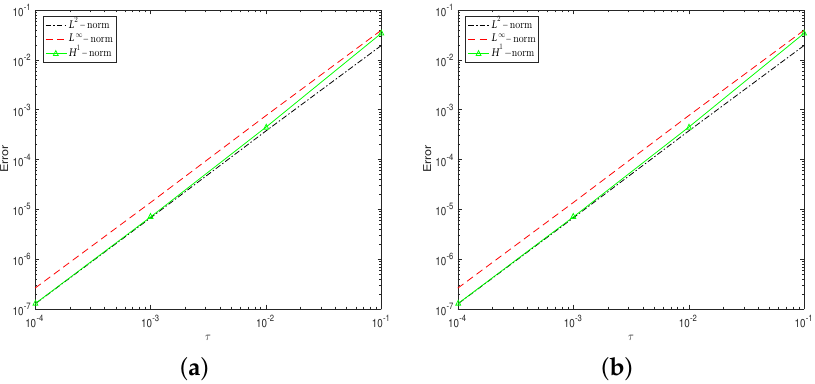
Figure 4. For T = 1, N x = N y = 10 and different β , the errors as a function of the time step τ . ( a ) β = 0.01; ( b ) β = 0.3.